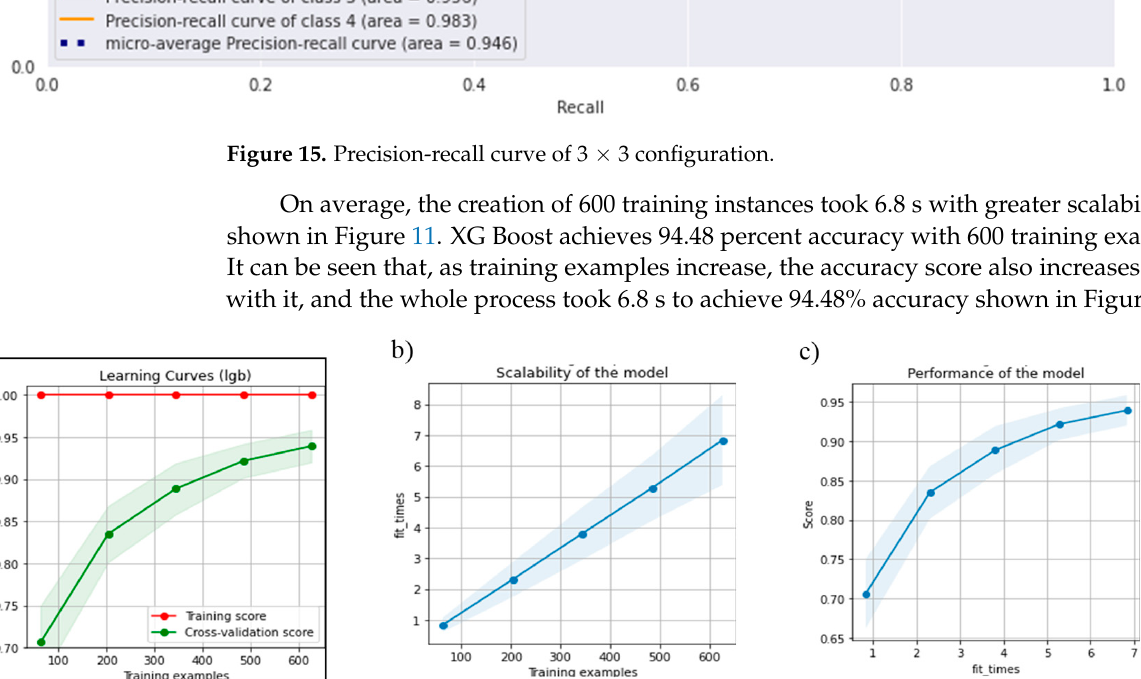
Figure 15. Precision-recall curve of 3*3 configuration.